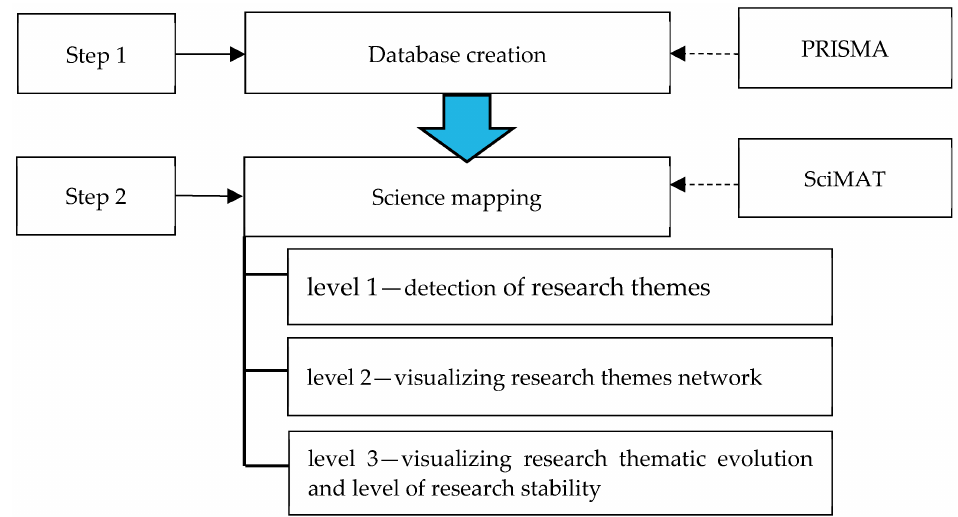
Figure 1. Conceptual map of the empirical procedure.